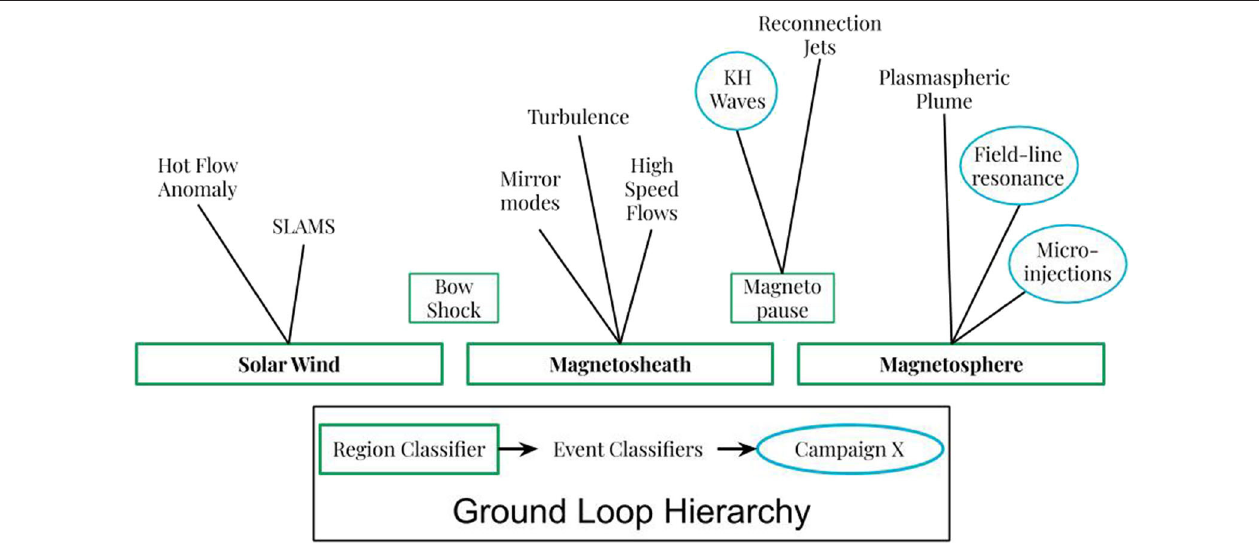
FIGURE 8 | A hierarchy of machine learning models to automate science objectives and reduce mission costs. Data is filtered through region classifiers (green rectangles) and passed to specialized event classifiers (black text) specific to those regions. Multiple event classifiers are activated together to automate science campaigns (blue